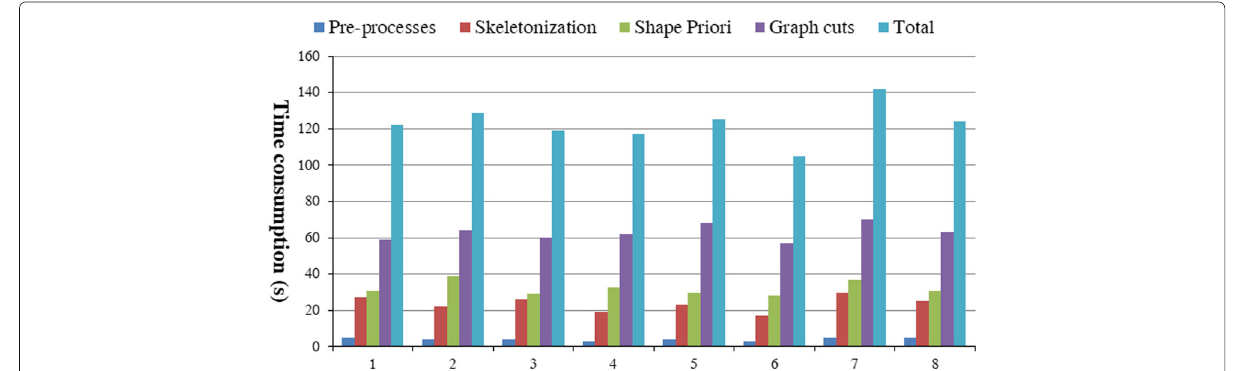
Fig. 14 Statistics of time consumption. Time consumption (in seconds) of procedures including the pre-process, skeletonization, shape priori, and graph cuts for 8